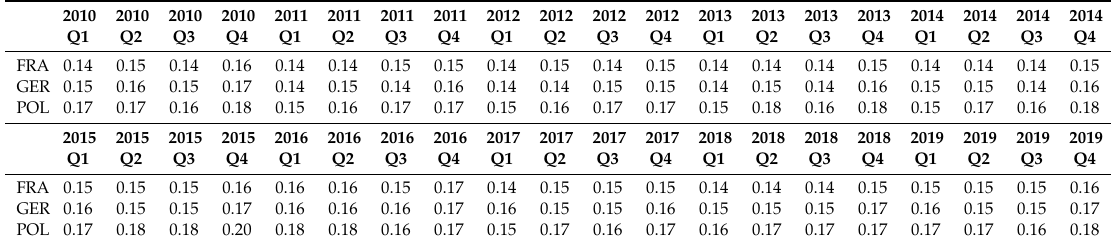
Table 1. Share of imports of capital goods in total imports (in %), own work, source: Eurostat.